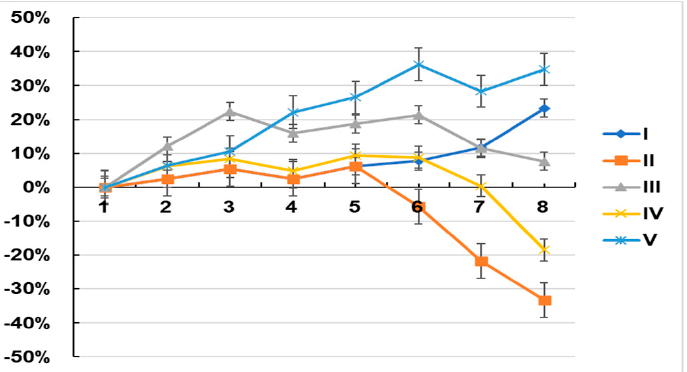
Figure 7. Data represent the mean ± SD of six independent experiments. ** p < 0.001 as compared to controls. The number of mice with tumors is 10 with four tumors per mouse. Mean values are body weights ± SD.